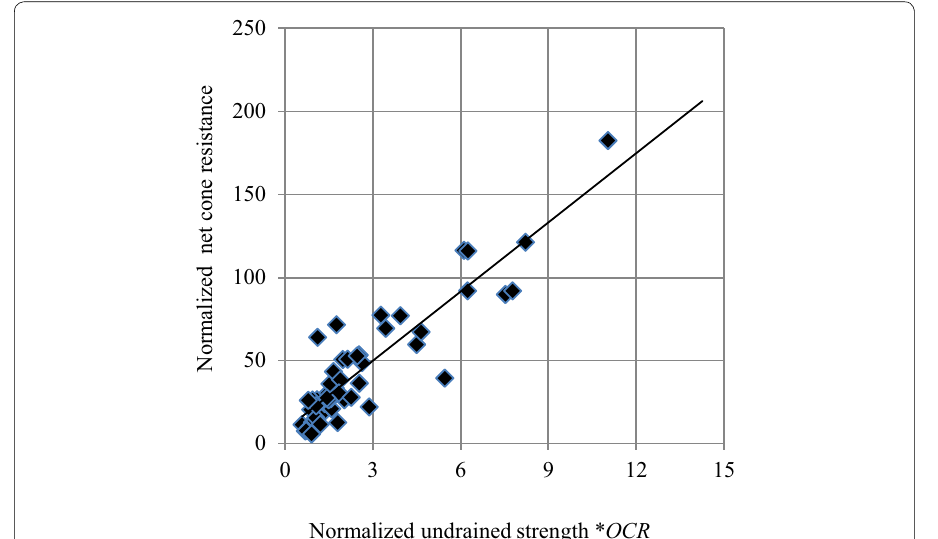
Fig. 6 Relationship of normalized net cone resistance and undrained strength of silt soils